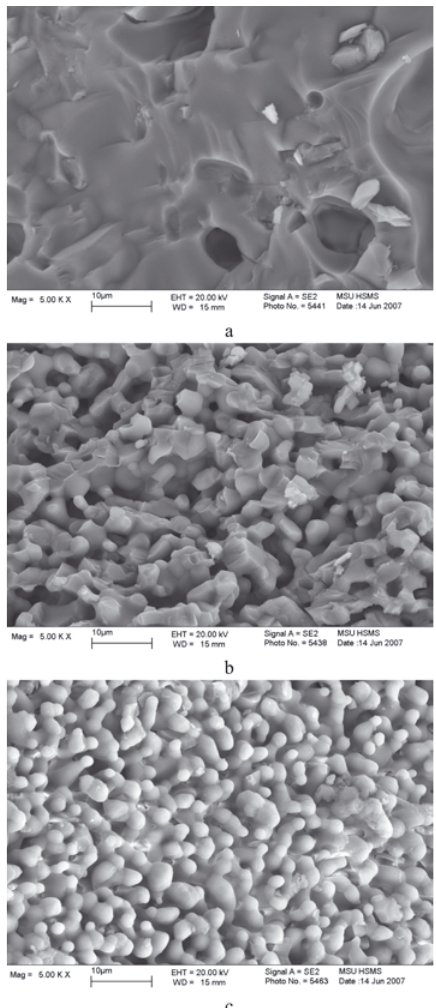
Figure 8. Micrographs of the samples from powders synthesized (b), 2